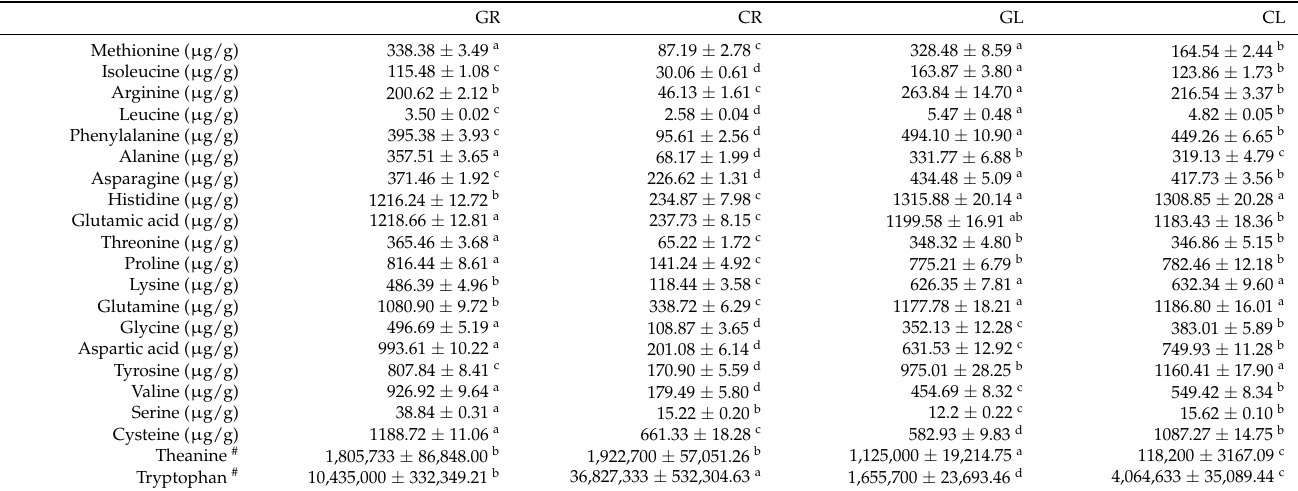
Table 1. Contents of amino acids in tea roots and leaves.